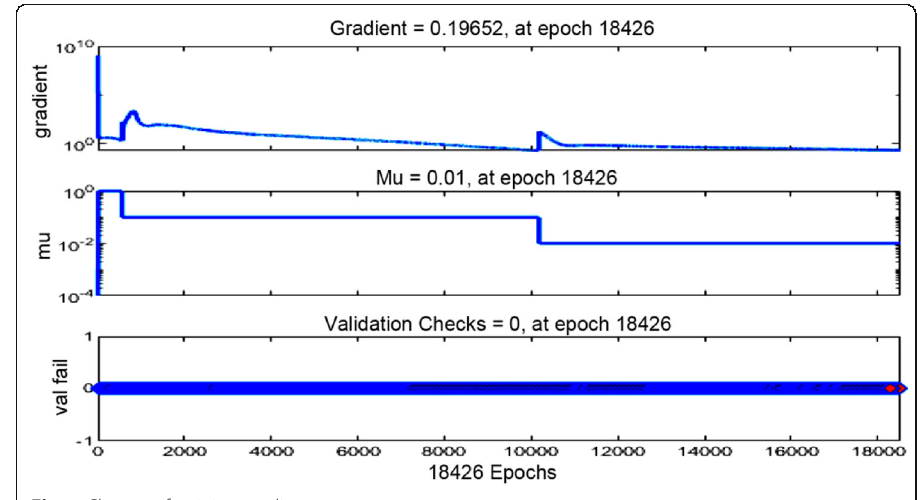
Fig. 5 Change of training gradient